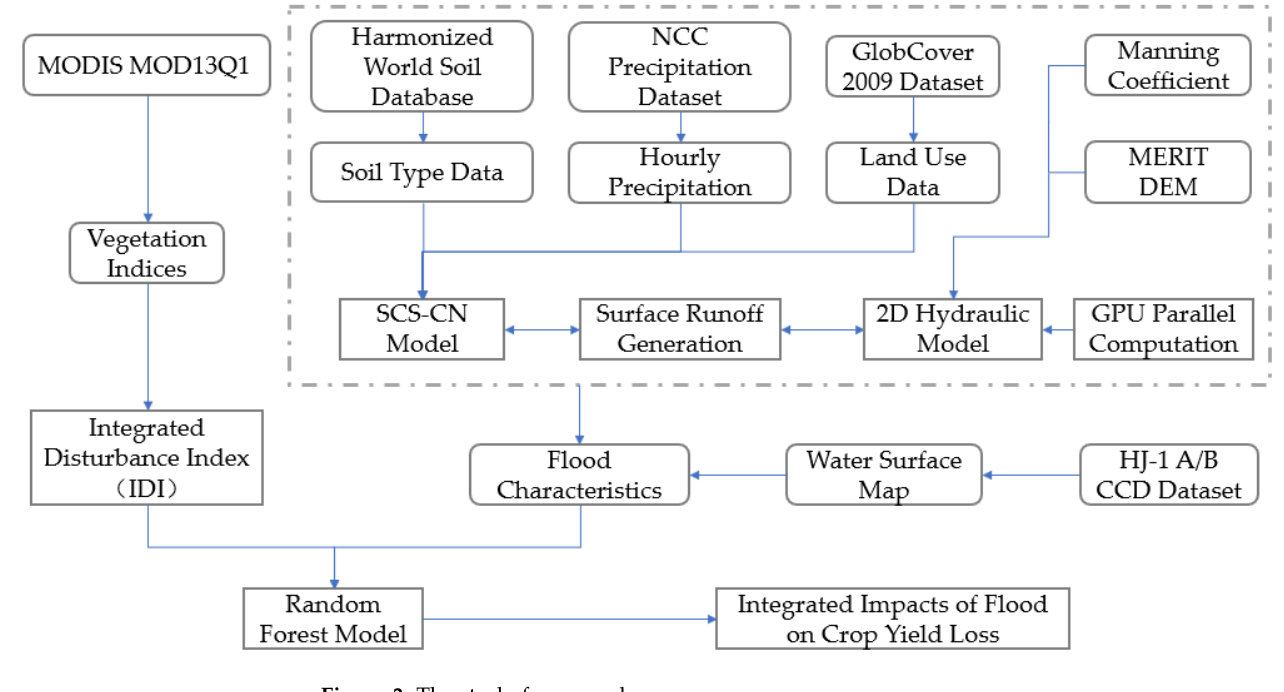
Figure 3. The study